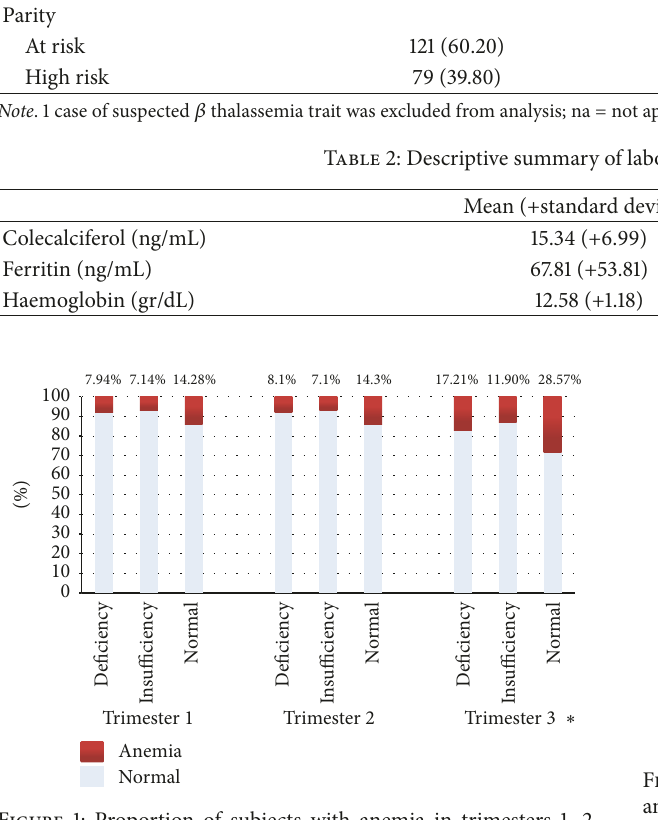
Figure 1: Proportion of subjects with anemia in trimesters 1, 2, and 3 by first trimester colecalciferol status. ∗ Relative risk (95% CI) for anemia in the third trimester among subjects with calciferol deficiency and insufficiency in the first trimester, combined = 2.96